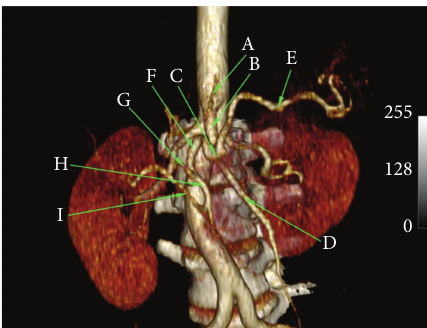
Figure 1: Reconstructed coronal CT images demonstrating the new anatomic variant. Key: left gastric artery—A; celiacomesenteric trunk—B; coeliac trunk—C; superior mesenteric artery—D; splenic artery—E; common hepatic artery—F; left hepatic artery—G; gas-